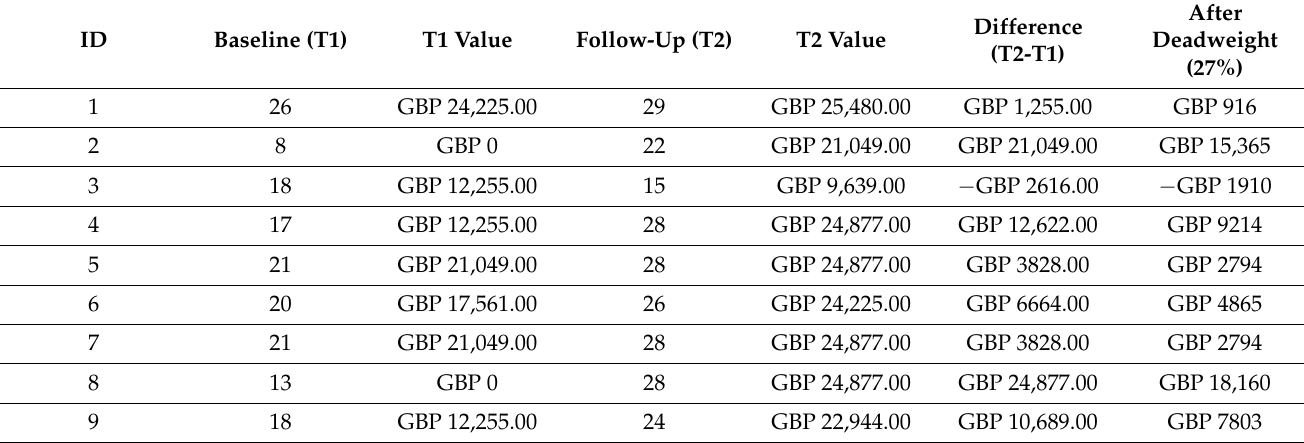
Table 8. Social value for online clients using the mental health social value